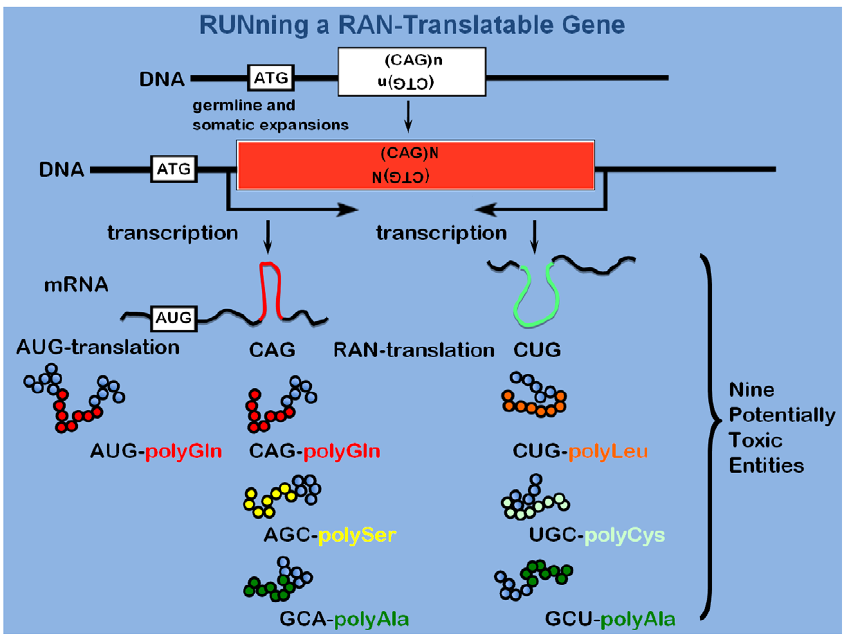
Figure 1. RUNning a RAN-gene. One DNA, two transcripts, seven possible reading frames, potentially nine toxic entities! Both CAG and CTG transcripts could be toxic [12,38], the AUG-initiated polyGln protein reading frame can be toxic, and each of the three reading frames from either the CAG or CUG transcript present six additional homopolymeric proteins, making a total of nine potentially toxic entities!